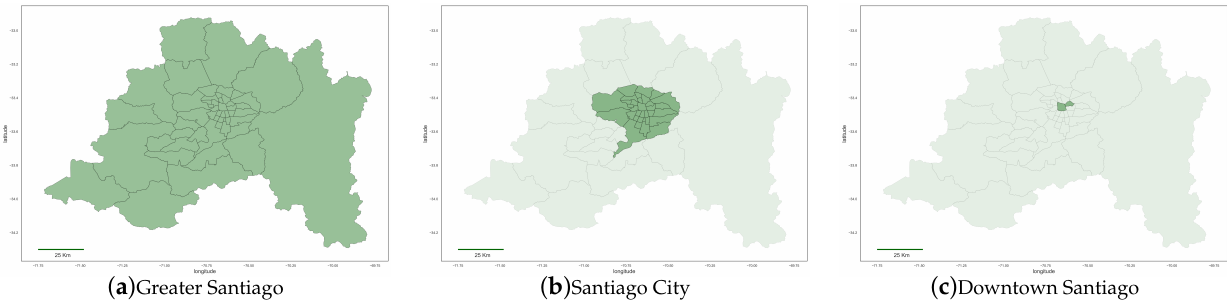
Figure 1. Santiago Metropolitan